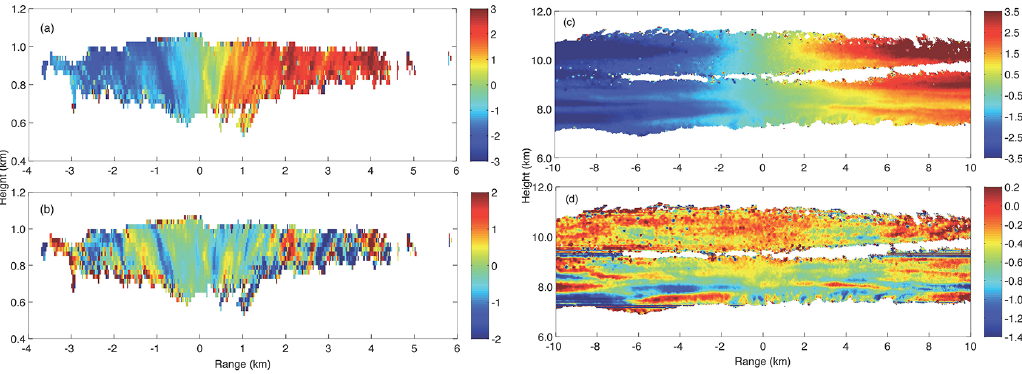
Fig. 11. Ka-SACR radar Doppler velocity 3-D gridding RHI planes of a stratocumulus during TCAP: (a) observed radial Doppler velocity and (b) retrieved vertical Doppler velocity component; Ka-SACR radar Doppler velocity 3-D gridding RHI planes of a cirrus at the SGP: (c) observed radial Doppler velocity and (d) retrieved vertical Doppler velocity